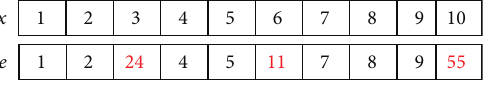
Figure 5: Attribution